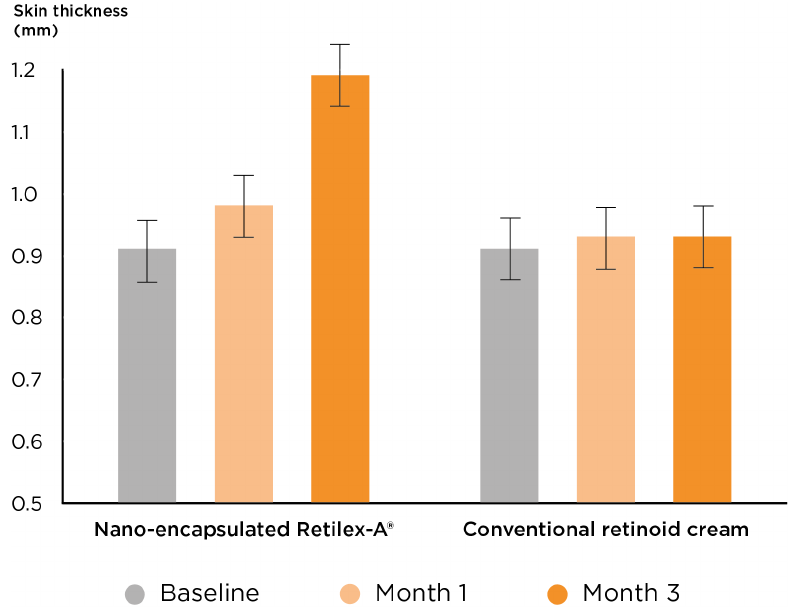
Figure 2. Mean changes in skin thickness (mm) of individuals using either Nourella ® cream contain- ing nano-encapsulated RetileX-A ® (left) or a matching cream containing a similar concentration of free retinyl palmitate (right); Error bars represent SD [41].